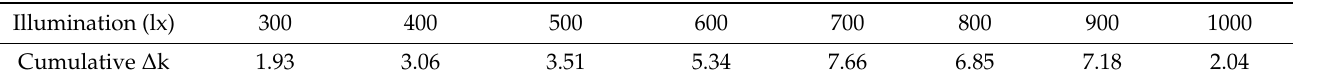
Figure 10. Trend of cumulative ∆ k value. Table 7. Cumulative ∆ k value